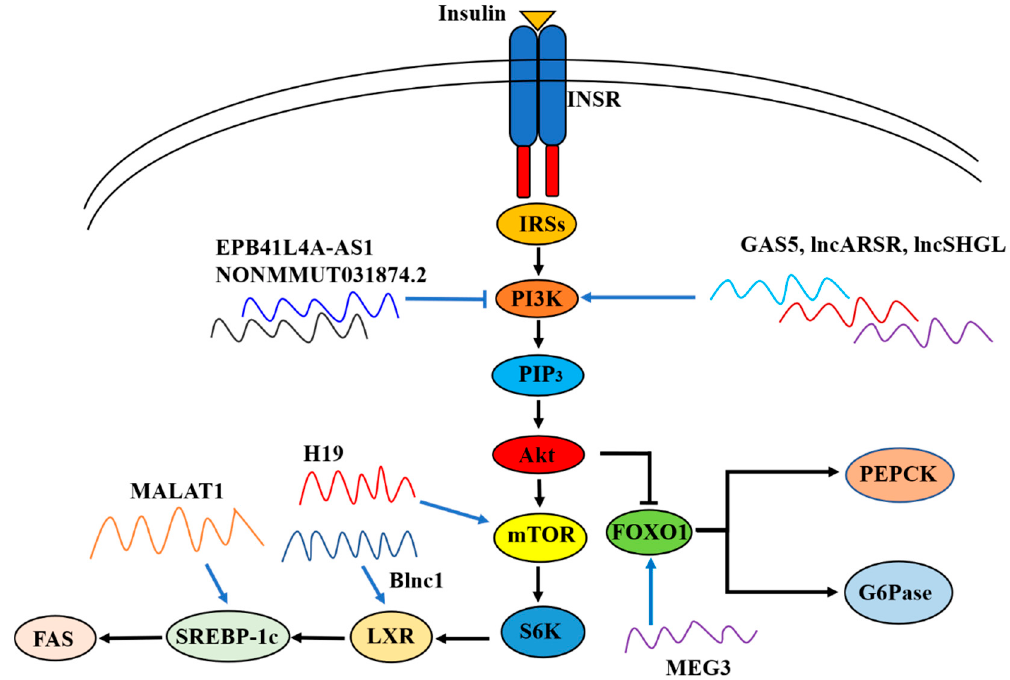
Figure 2. LncRNAs are important regulators of the insulin signaling pathway and glycolipid metabolism in the liver. LncRNAs including GAS5, lncARSR and lncSHGL positively regulate the PI3K/Akt pathway, while lncRNAs including EPIB41L4A-AS1 and NONMMUT031874.2 negatively regulate the PI3K/Akt pathway in the liver. Other lncRNAs interact with downstream molecules of the PI3K/Akt pathway to regulate glucose and lipid metabolism: H19 activates mTOR complex, MEG3 stimulates FOXO1 and its downstream gluconeogenic enzymes, Blnc1 activates the LXR/SREBP-1c pathway, and MALAT1 upregulates the expression of SREBP-1c to promote hepatic gluconeogenesis and lipid deposition. Akt, protein kinase B; FAS, fatty acid synthase; FOXO1, forkhead box o1; G6Pase, glucose-6-phosphatase; INSR, insulin receptor; IRSs, insulin receptor sub- strates; LXR, liver x receptor; mTOR, mammalian target of rapamycin; PEPCK, phosphoenolpyruvate carboxykinase; PI3K, phosphatidylinositol 3-kinase; PIP3, phosphatidylinositol (3,4,5)-triphosphate; S6K, ribosomal protein S6 kinase; SREBP-1c, sterol regulatory element binding